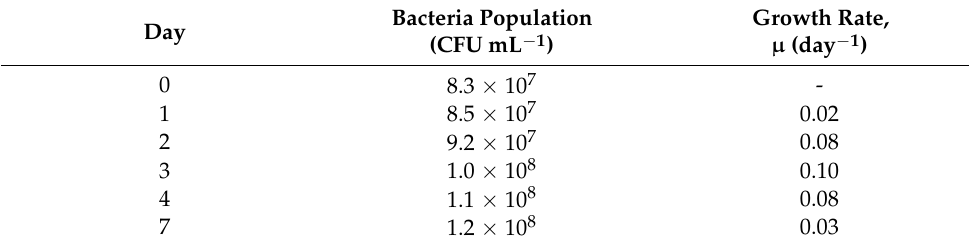
Table 2. Population and specific growth rate of bacteria on biodegradation